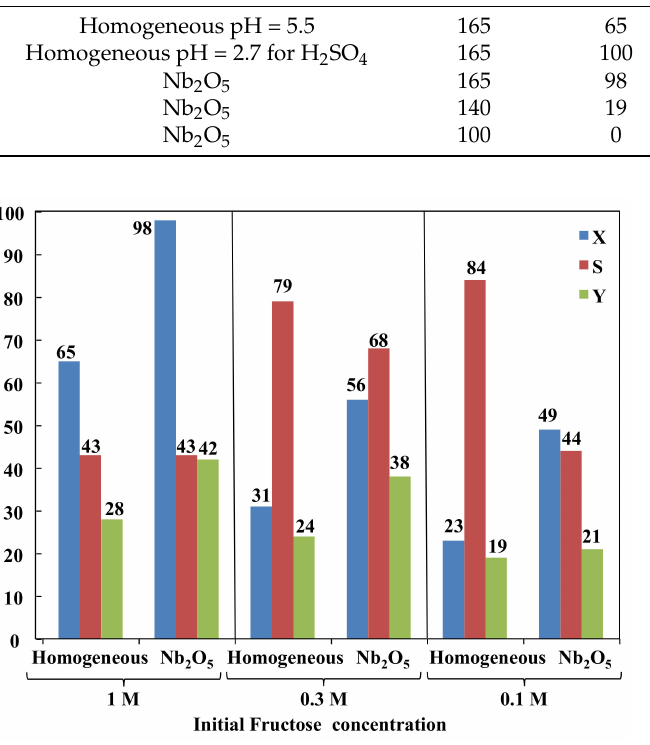
Table 3. Conversion of fructose (X), selectivity (S) and yield (Y) to HMF obtained in catalytic experiments in homogeneous regime at natural pH (pH = 5.5), in the presence of H 2 SO 4 (pH = 2.7) or Nb 2 O 5 catalyst (2 g L − 1 ), carried out for 3 h with an initial concentration of fructose equal to 1 M. Catalyst. Homogeneous pH = 5.5